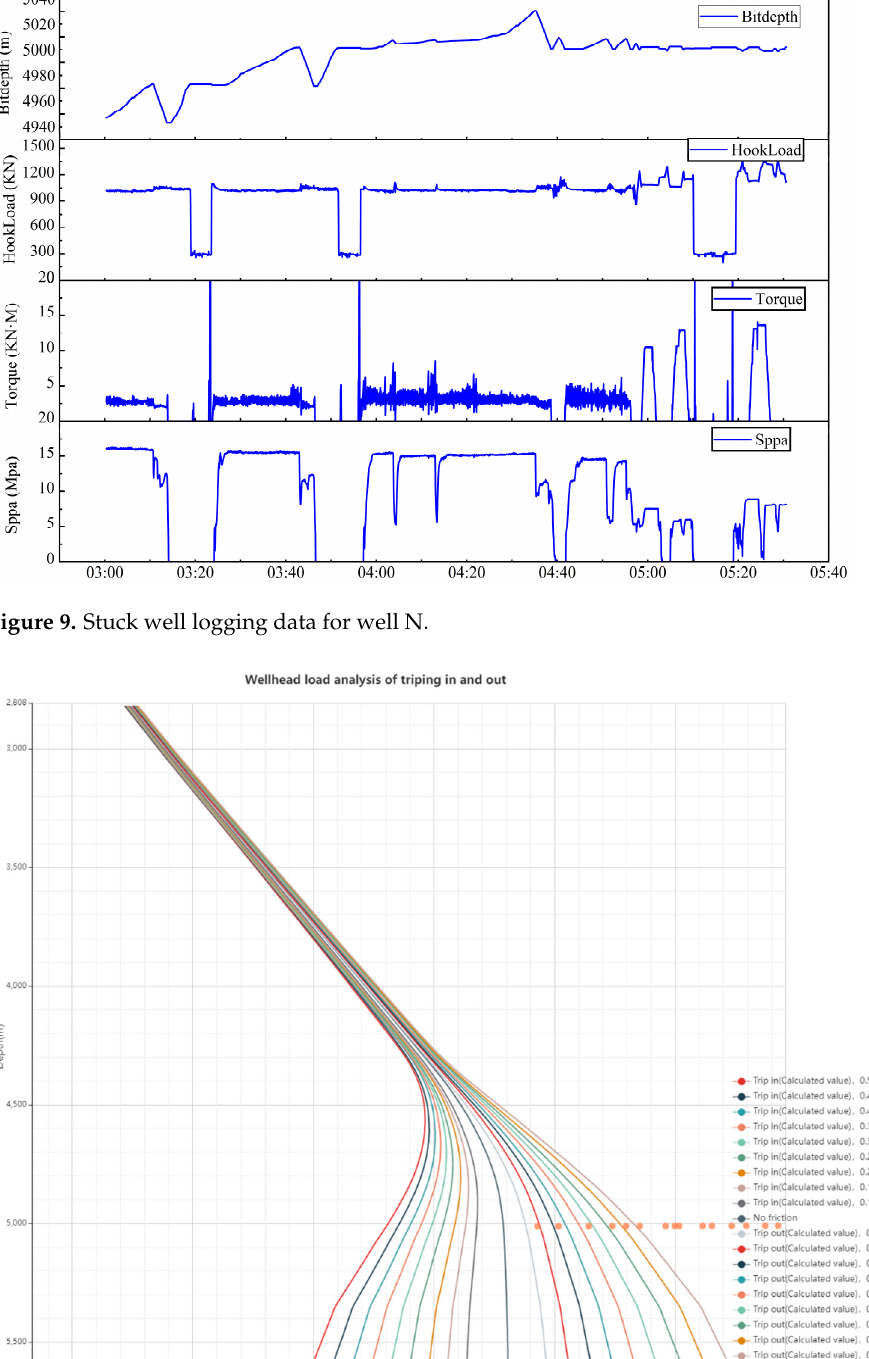
46.94 Table 8. Current bottom hole assembly (BHA) for well N open hole. Tool